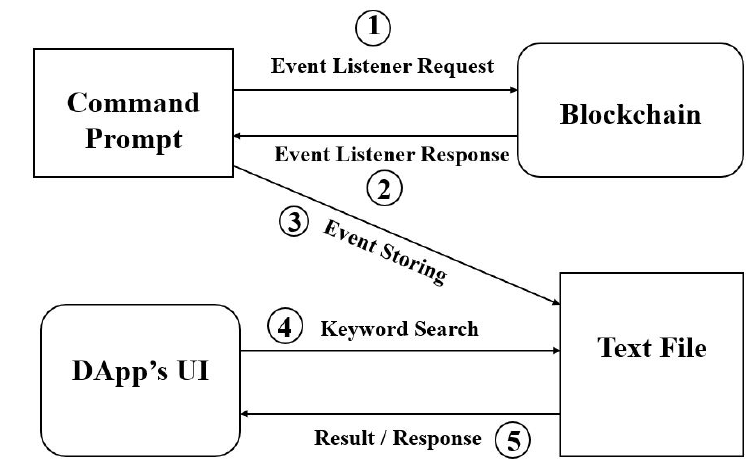
Figure 6. Keyword Search Function of the proposed DApp.